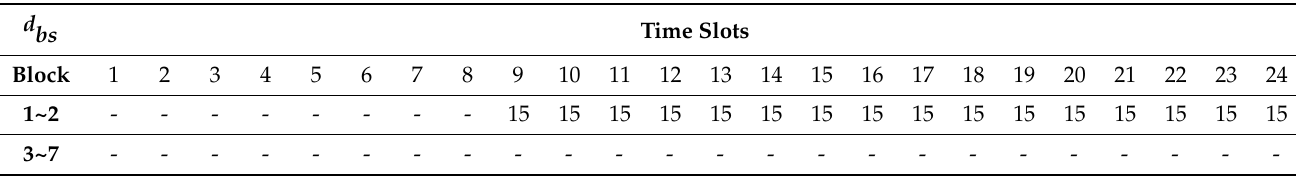
Table 4. Demurrage cost for each truck appointed at block b at time slot s .